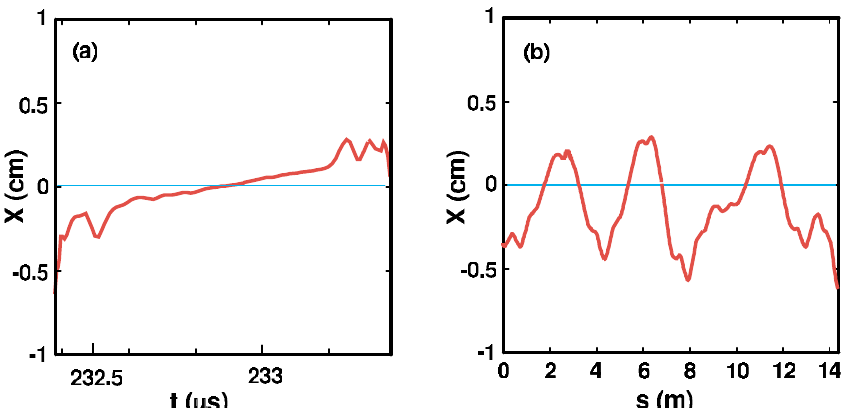
FIG. 2. (Color) Beam-centroid displacement for the nominal lattice with 34 induction cells per lap, illustrated by (a) a “snapshot” showing the displacement along the pulse at the end of 15 laps and (b) a “history” of the beam head during the last lap.